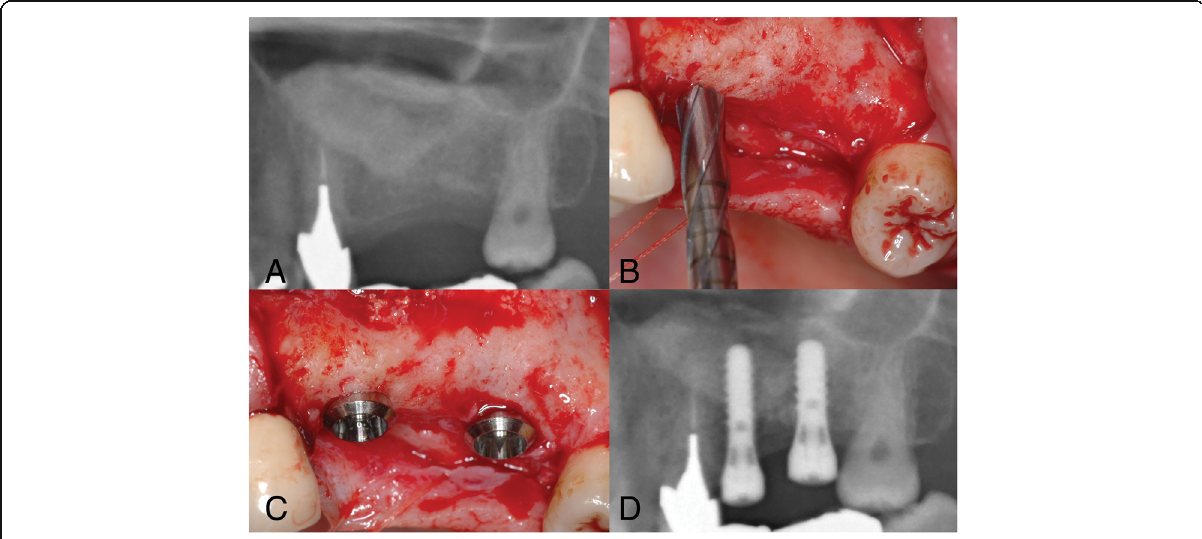
Fig. 1 Images of patient # 5 (9-month healing time). a. Radiograph of the left maxillary sinus: situation 9 months after the maxillary sinus floor elevation procedure. b. With a trephine drill, the implant osteotomy is made and the biopsy is obtained. c. Clinical situation after placing two Straumann® SLA implants in the left posterior maxilla. d. Radiograph of two Straumann® SLA implants in the left posterior